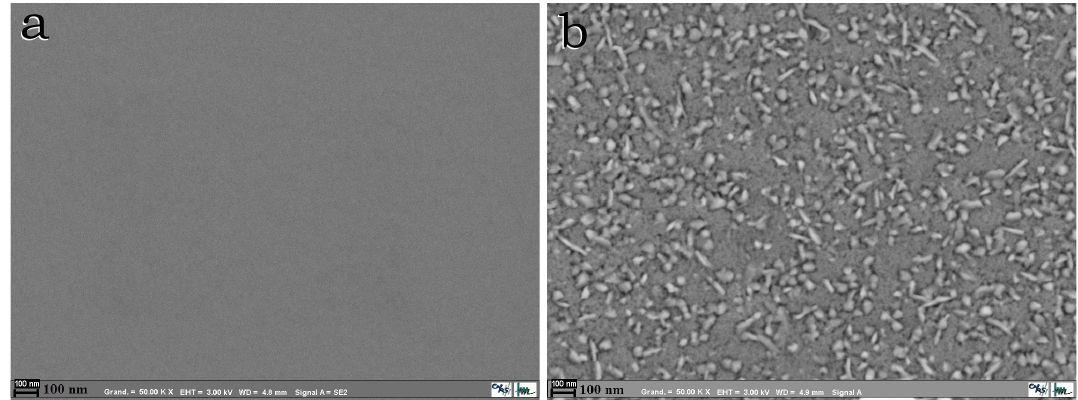
Figure 1. SEM images of TiO (magnification ×50,000).